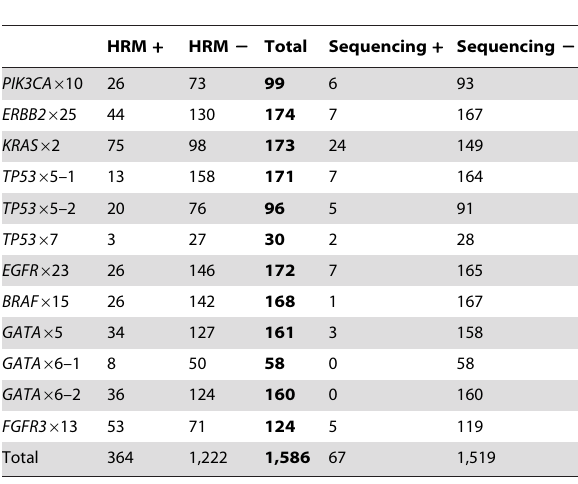
Table 6. Results of mutation screening by HRM and sequencing from the paraffin-embedded samples.